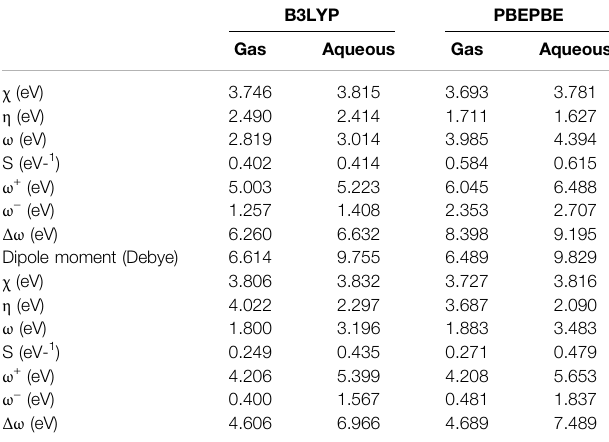
TABLE7| GlobalquantumchemicaldescriptorsoftheSMZdrugcalculatedusing the B3LYP and PBEPBE methods with 6-31+G (d,p) basis sets in the gas phase and aqueous solution. The upper part of the Table corresponds to the values obtained using the computed ∈ H and ∈ L values, while the lower part of the table corresponds to values obtained using the VIPs and